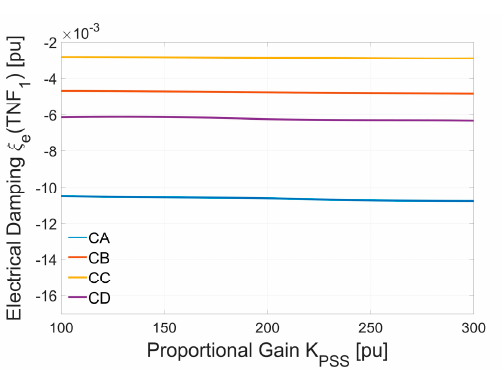
Figure 23. Electrical damping ξ e (TNF 1 ) related to K PSS variations. Figure 24. Sensitivity coefficient of electrical damping ξ e (TNF 1 ) related to K PI . Figure 25. Sensitivity coefficient of electrical damping ξ e (TNF 1 ) related to K PLL .